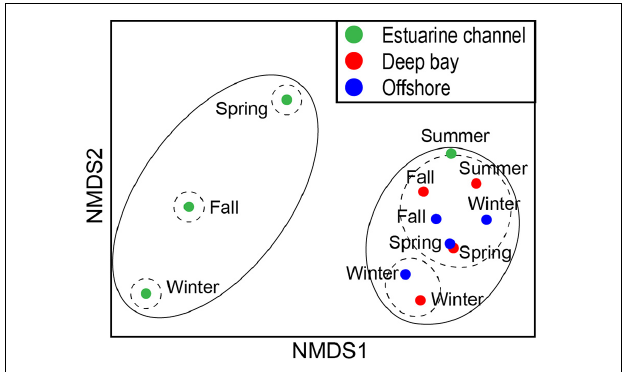
FIGURE 2 | Two-dimensional non-metric multidimensional scaling (nMDS) ordination showing spatially separated nekton community assemblages between estuarine and coastal sites of Gwangyang Bay over four seasons. Solid and dashed lines represent 20 and 40% similarity boundaries,